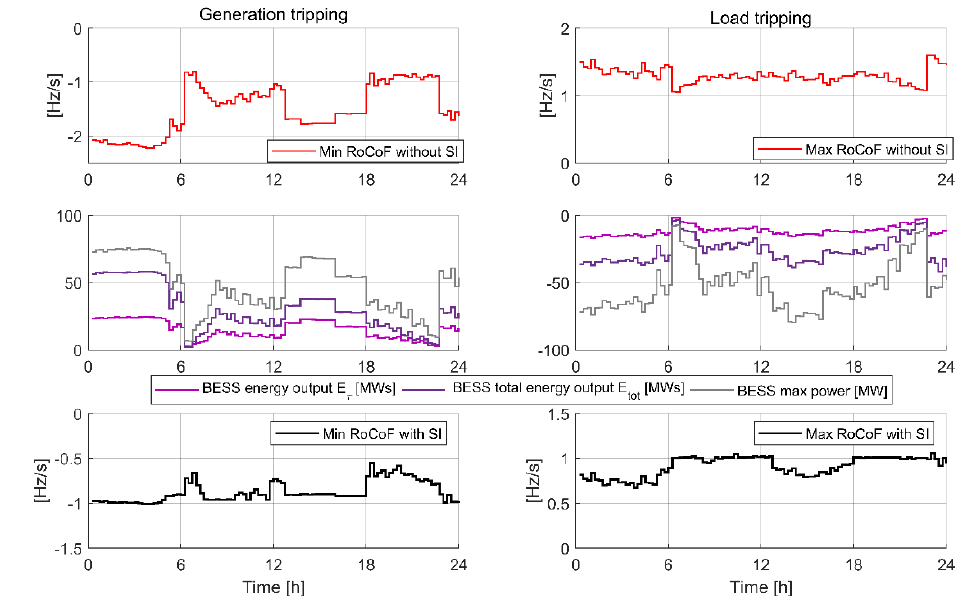
Figure 8. Effect of SI activation on rate of change of frequency (RoCoF) for the 24 h planning period for generation tripping (left) and load tripping (right): RoCoF for the scenario with synchronous and wind generation (top), BESS power and energy output (middle), RoCoF for the same scenario with SI activated.